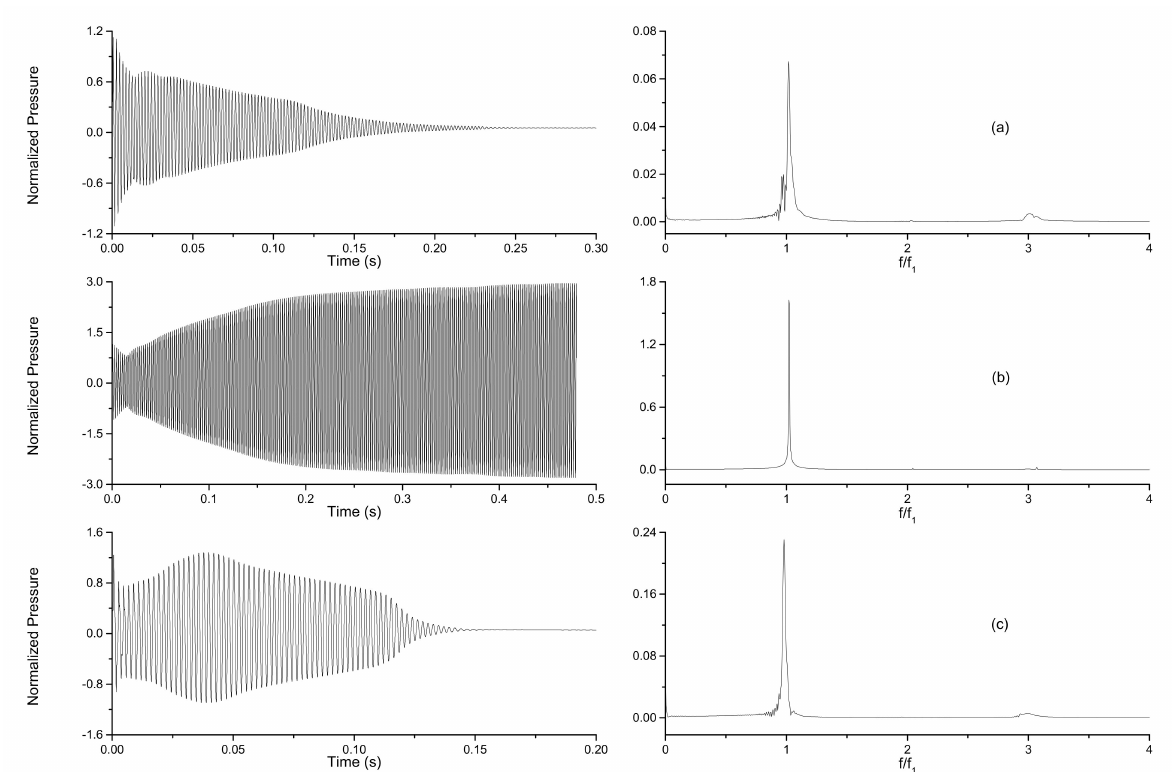
Figure 7. Time histories of static pressure at the monitoring point p 1 of square pipe (case 2), St = 0.26 ( a ), St = 0.30 ( b ), St = 0.42 ( c ).